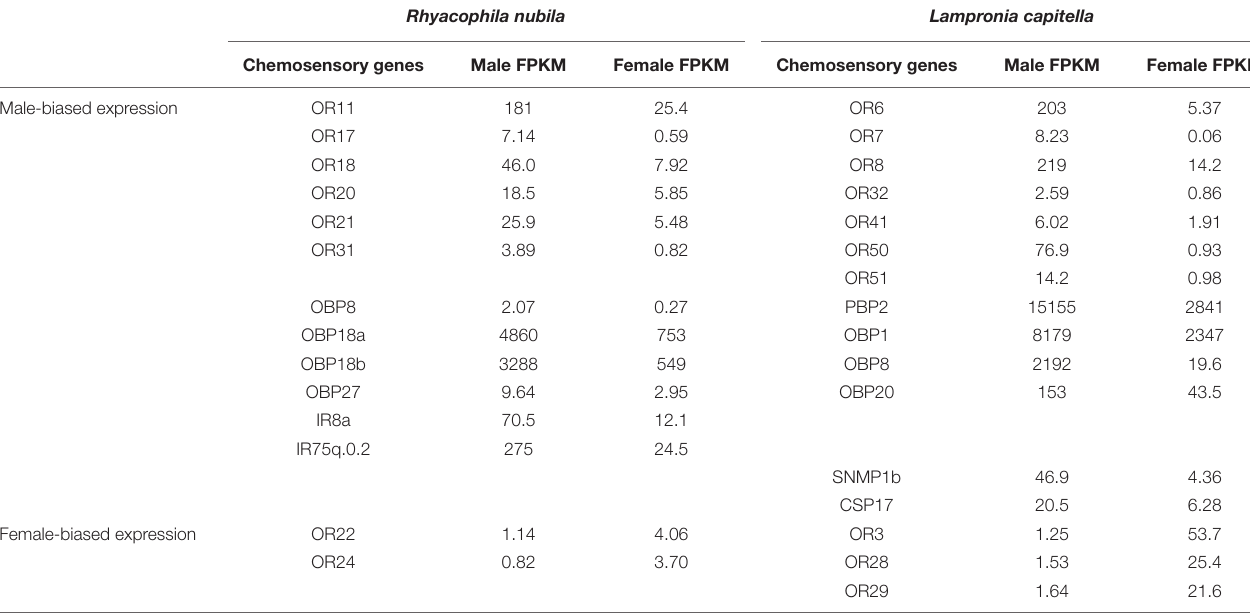
TABLE 2 | Chemosensory genes from R. nubila and L. capitella with estimated sex-biased expression ( > 3-fold difference), presented as FPKM (Fragments Per Kilobase of transcript per Million mapped reads)